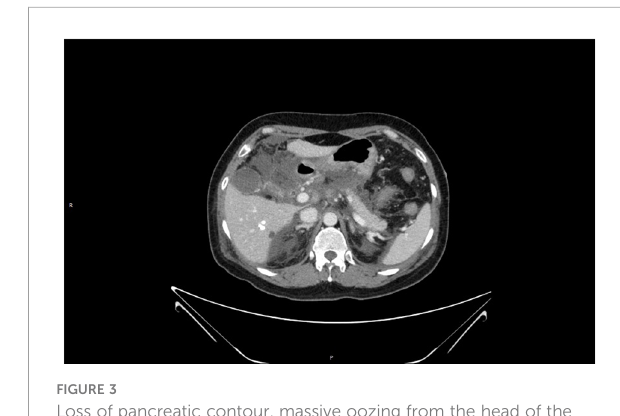
FIGURE 2 Peripancreatic fl uid with infection, CT-guided puncture, and drainage was performed.